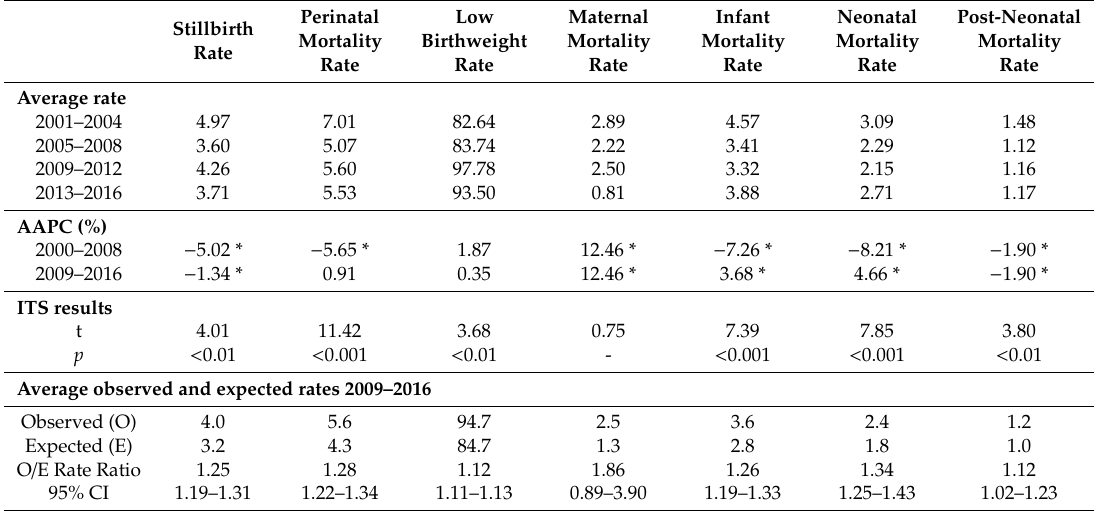
Table 1. Trends in perinatal and infant mortality in Greece, and expected rates 2009–2016. Post-neonatal Neonatal Infant Maternal Low Perinatal Stillbirth Mortality Mortality Mortality Mortality Birthweight Mortality Rate Rate Rate Rate Rate Rate Rate Average rate